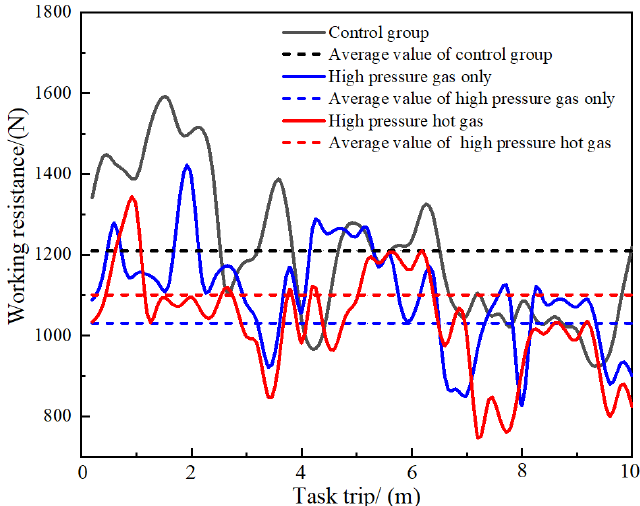
Figure 15. Working resistance tests on the subsoiling shovel under high-pressure hot air curtain and standard conditions.